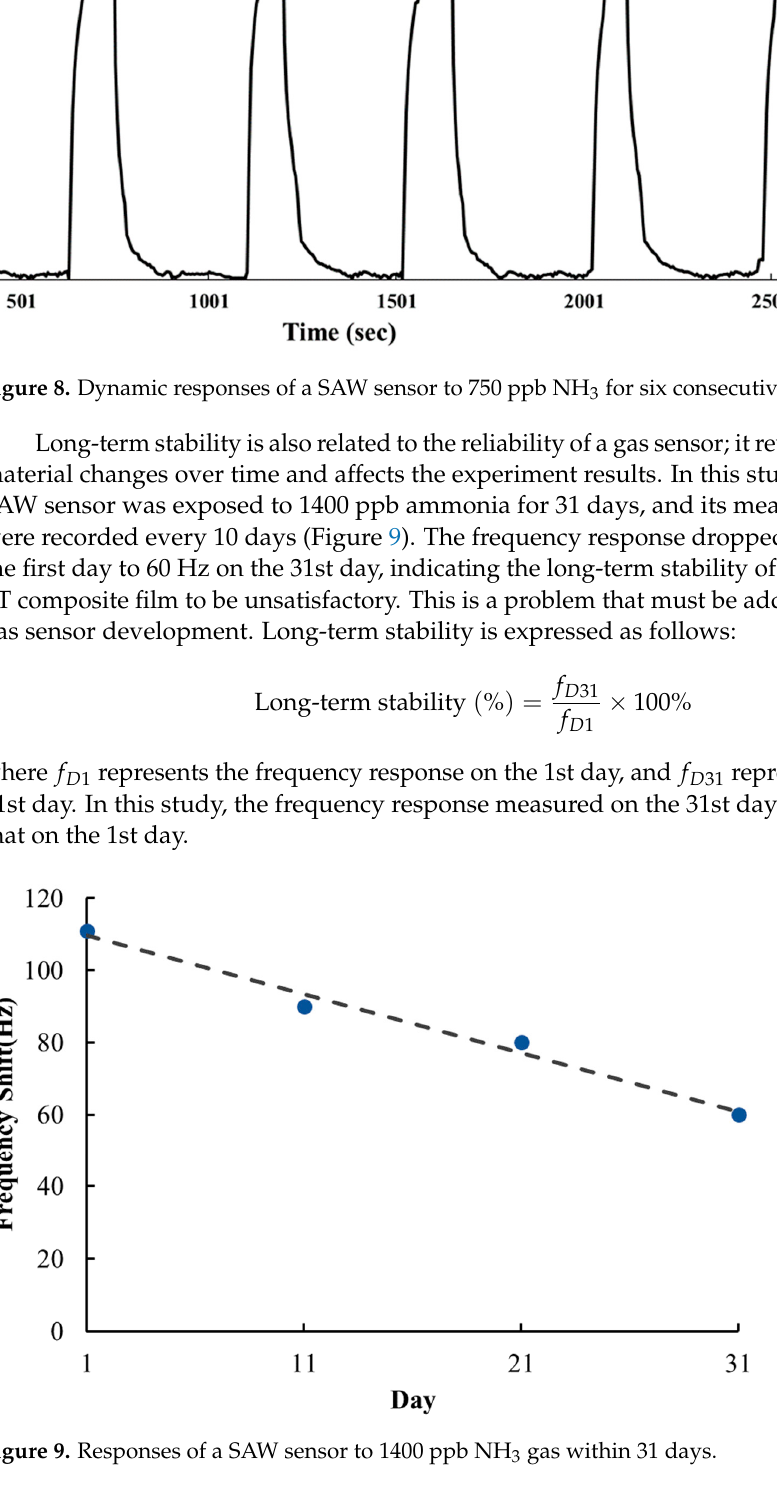
Figure 10. Sensitivity of a SAW sensor to 0.6 ppm NH 3 gas, 1 ppm CO 2 gas, 1 ppm CO gas, and 1 ppm H 2 gas. 4. Conclusions This study employed a SAW sensor coated with rGO/DPP2T-TT composite film to detect ammonia at the sub-ppm concentration levels in dry air to determine its potential for applications in biomedical sensing. As shown in the FESEM, EDS, and XRD images, the rGO/DPP2T-TT composite film was successfully synthesized and exhibited numerous wrinkles and a rough structure, which is crucial to gas detection. According to the exper- imental results, the frequency response of the prepared SAW sensor coated with rGO/DPP2T-TT composite film to 500–1400 ppb ammonia increased linearly as the am- monia concentration increased. The sensitivity of the SAW sensor coated with the rGO/DPP2T-TT composite film was calculated as 55 Hz/ppm, and its frequency response to 500 ppb ammonia was 35 Hz, indicating that its minimal detectable ammonia concen- tration was 425 ppb. According to its recovery time, this sensor did not exhibit excellent reversibility because the strong bond between the ammonia and rGO rendered desorption difficult. The repeatability of the SAW sensor coated with the rGO/DPP2T-TT composite film was 93%. However, its frequency response on the 31st day was only 54% of that on